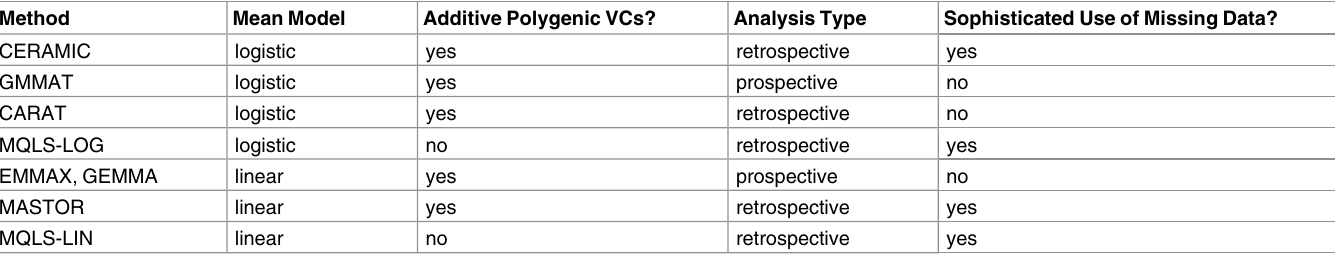
Table 1. Some Relevant Features of the Methods Compared in